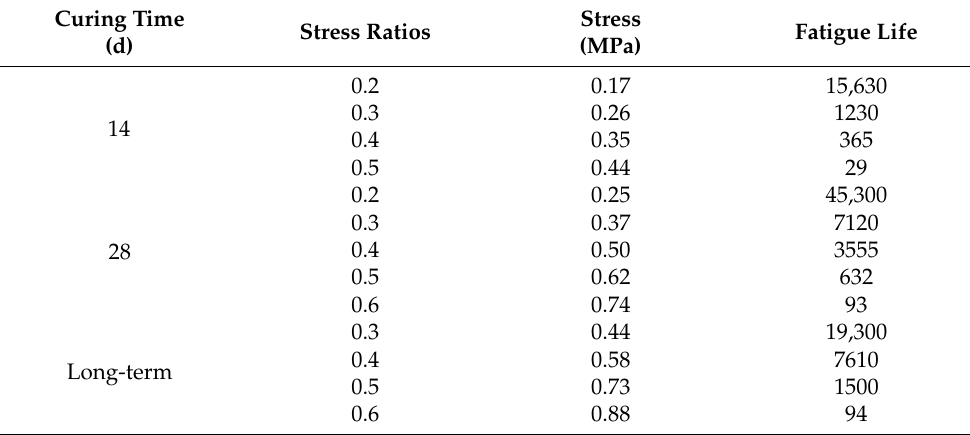
Table 5. The fatigue life of CRME with different curing times under different stress ratios.